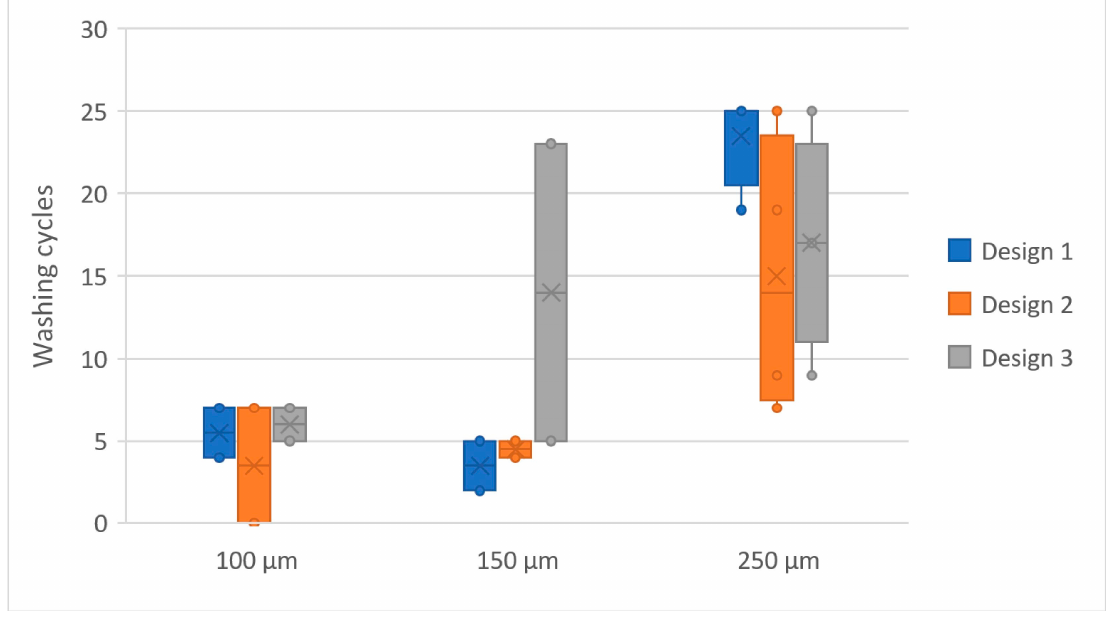
Figure 12. Comparison of the lifetime of a track as a function of TPU thickness.